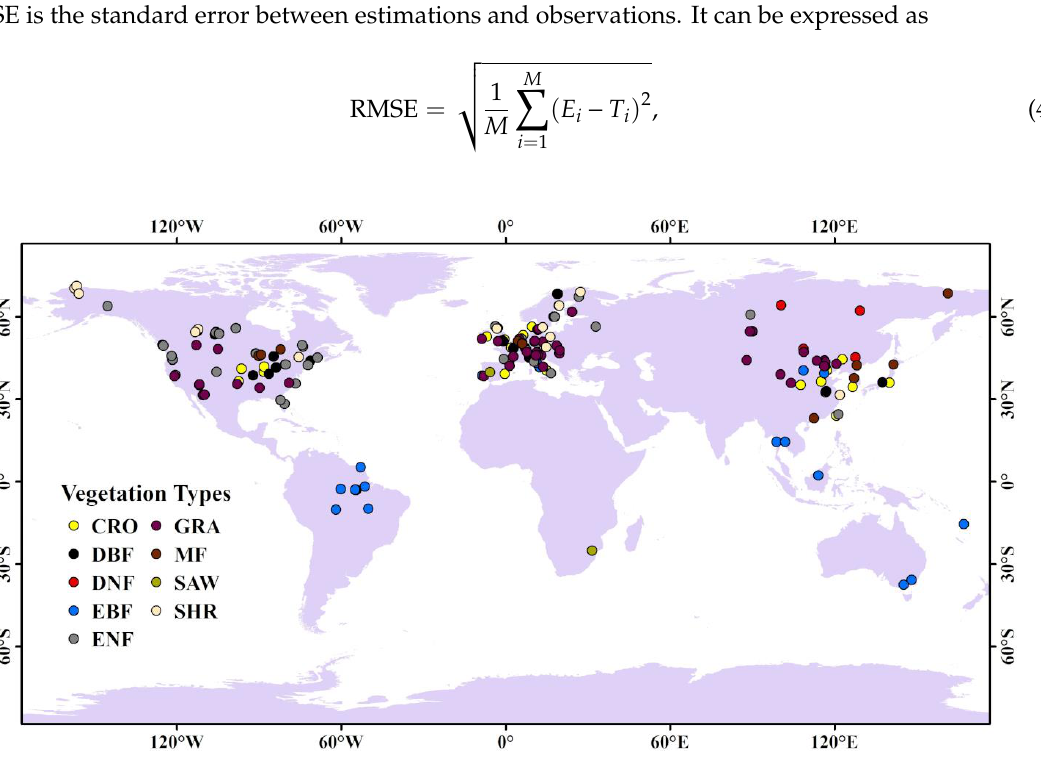
Figure 1. Distribution of the in-situ measurements used in this study.